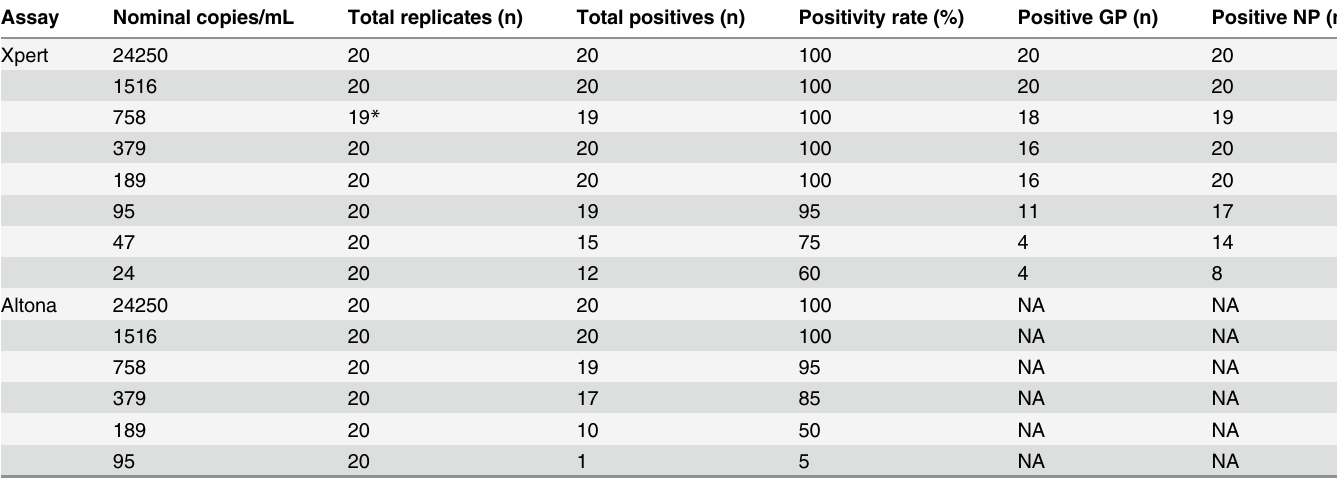
Table 3. Limit of Detection of the Xpert 1 Ebola Assay and Altona RealStar 1 Ebolavirus RT-PCR Kit 1.0 using Inactivated EBOV Yambuku- Mayinga. Assay